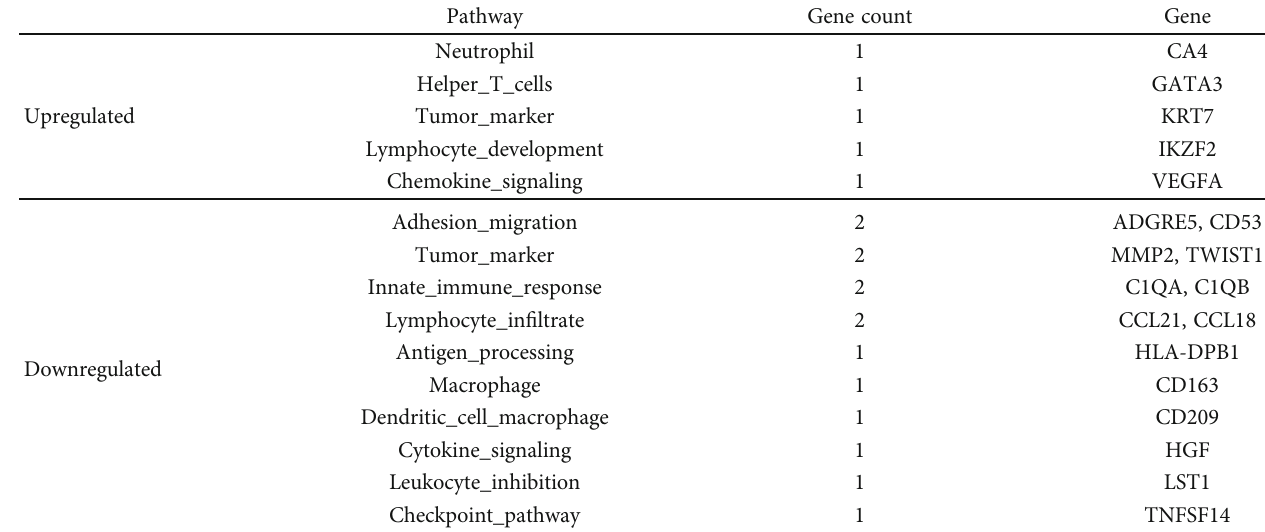
Table 4: Di ff erences of a gene in patients with di ff erent curative e ff ects after neoadjuvant